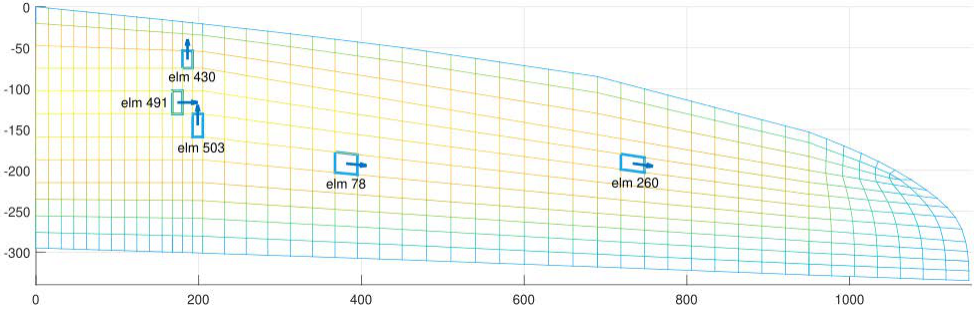
Figure 12. Optimal strain gauges configuration.